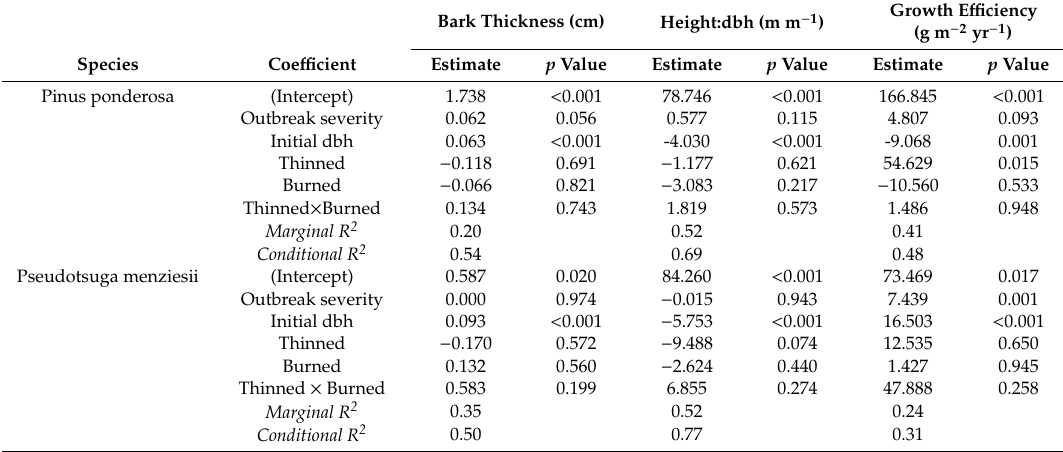
Table 3. Linear mixed-e ff ects model coe ffi cients for individual tree (DBH > 25 cm) disturbance resistance metrics (height-to-diameter, bark thickness, and growth e ffi ciency). “(Intercept)” coe ffi cient refers to the Control treatment. Note that the “Thinned” factor refers to Thin-only and Thin + Burn treatment units, while the “Burned” factor refers to Burn-only and Thin + Burn treatment